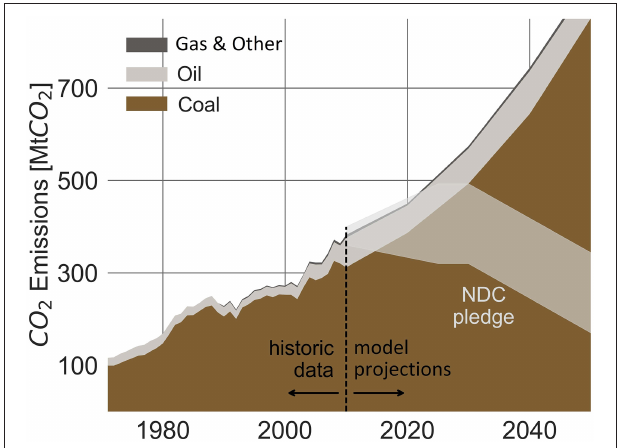
FIGURE 1 | South Africa’s energy-related CO 2 emissions as recorded in the past (1971–2010) and as calculated for a business-as-usual scenario per emissions source. The fair shaded area shows South Africa’s NDC reduction